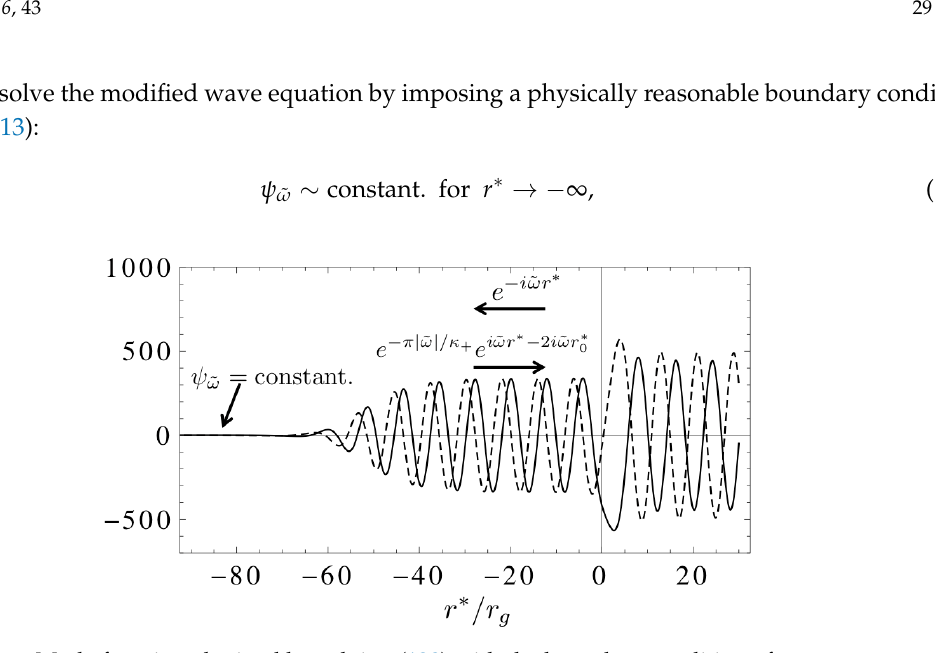
Figure 13. Mode function obtained by solving (128) with the boundary condition of ψ ˜ ω = constant. for r ∗ ∞ → −